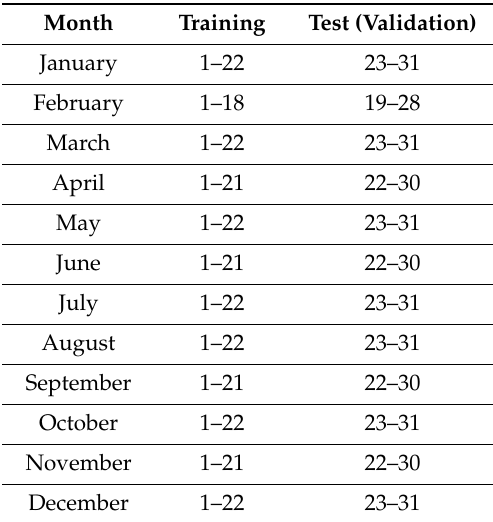
Table 5. Datasets for the conditional generative adversarial nets (CGAN) model (2017): Time = 04:00 UTC (daytime) / 16:00 UTC